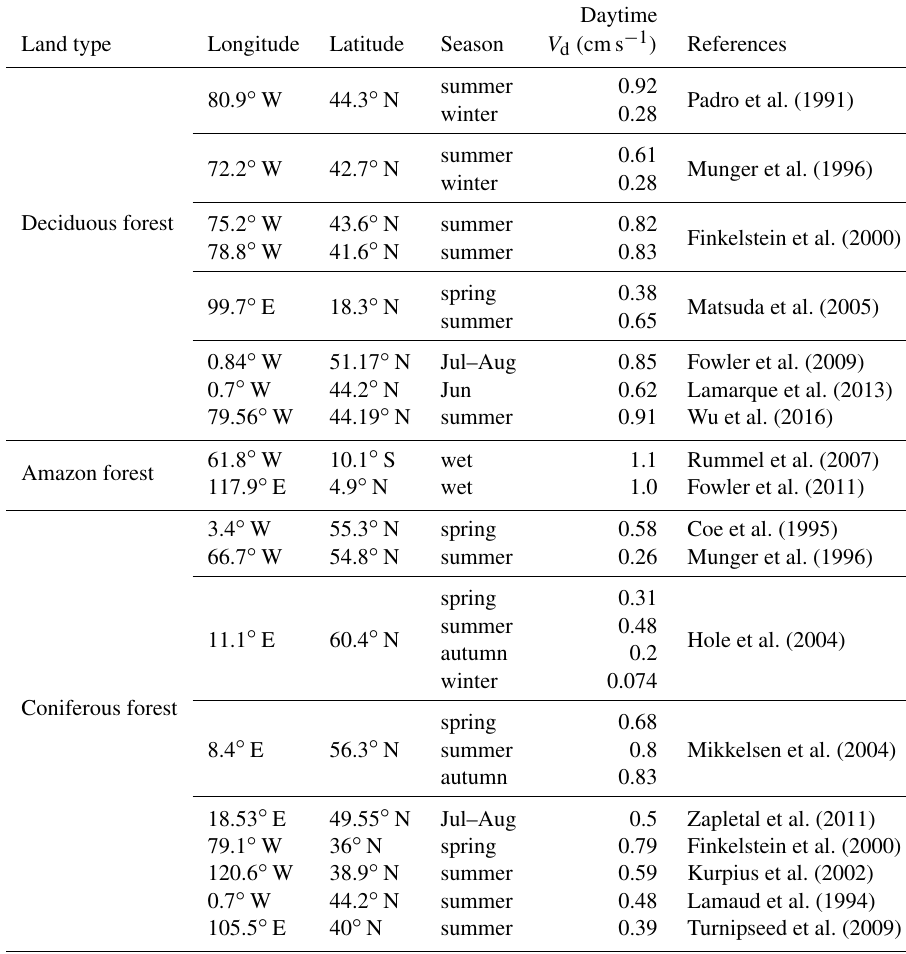
Table 2. List of measurement sites used for dry deposition